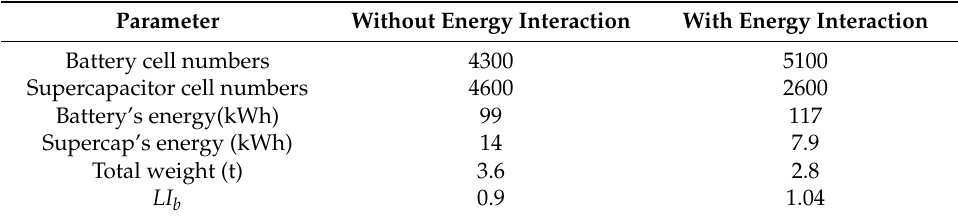
Table 4. Sizing optimization